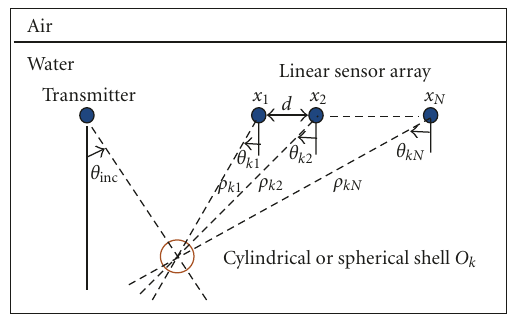
Figure 1: Geometry configuration of the k th object